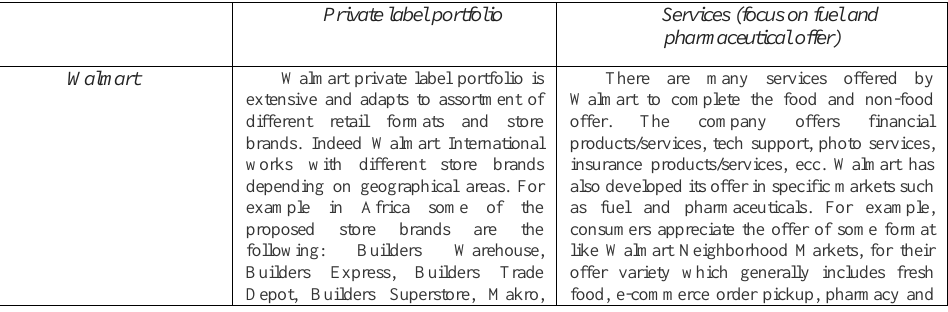
Table 5 : Private Label Portfolio and Services 6 of the three Largest Global Retailers Ranked by